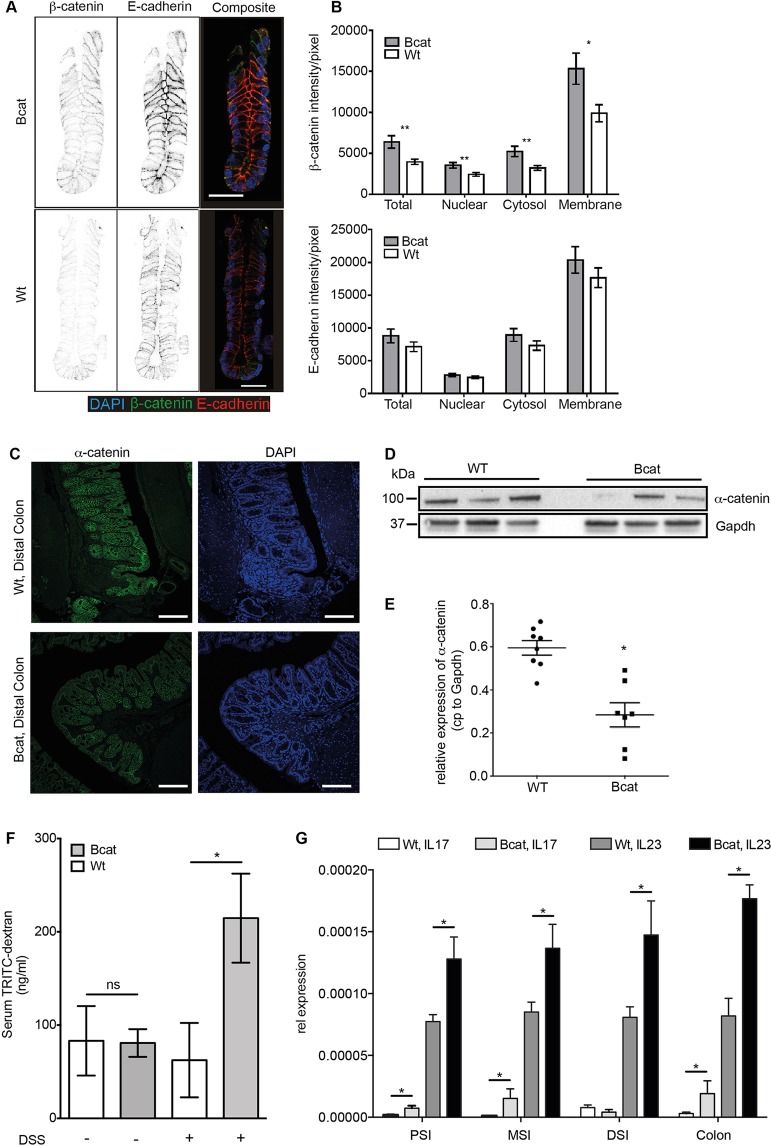
Intestinal permeability defect in Bcat mice is associated with mislocalization of membrane-associated proteins. (A) β-catenin and E-cadherin staining on isolated colonic crypts from Bcat and Wt mice. In the composite image, β-catenin is stained green, E-cadherin red and DAPI-labeled cell nuclei blue (scale bar=30 µm). (B) Quantification of staining intensity of β-catenin (top panel) and E-cadherin (bottom panel) in the indicated subcellular compartments (*P<0.05, **P<0.01, single-factor ANOVA, n=15 Bcat and n=24 Wt mice). (C) Confocal immunofluorescence images of α-catenin (green) in distal colon of Bcat and Wt mice. DAPI (blue) labels nuclei (scale bar=100 µm). (D) Western blot analysis of α-catenin protein expression in colonic shake preparations of Wt and Bcat mice. Shown is a representative western blot from one of three independent experiments. Each lane represents one mouse. Gapdh was used as loading control. (E) Scatter plot showing the expression levels of α-catenin protein normalized to Gapdh in colonic shake preparations of Wt and Bcat mice (*P<0.05; n=9 mice per genotype). (F) Intestinal permeability determined by the absorbance of TRITC-dextran in the serum 4 h after oral gavage of TRITC-dextran (4 kDa) in Wt and Bcat mice. A cohort of mice was also challenged with 2% DSS in the drinking water for 16 h prior to the TRITC-dextran gavage (*P<0.05, n=5-8 mice per genotype). (G) mRNA expression of IL-17 and IL-23 cytokines in proximal (PSI), middle (MSI) and distal small intestine (DSI) as well as colon of Wt and Bcat mice (*P<0.05, n=3 mice per genotype).